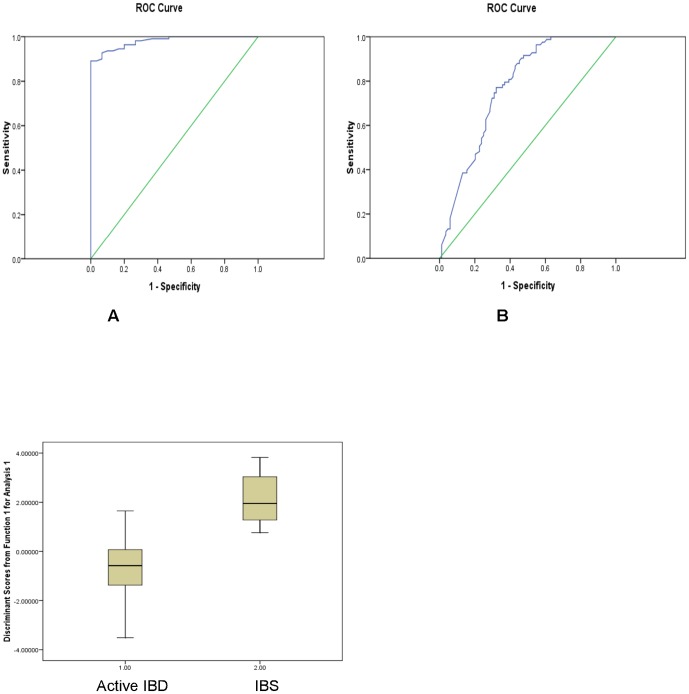
Box and Whisker plot of discrimination of IBS from active IBD.